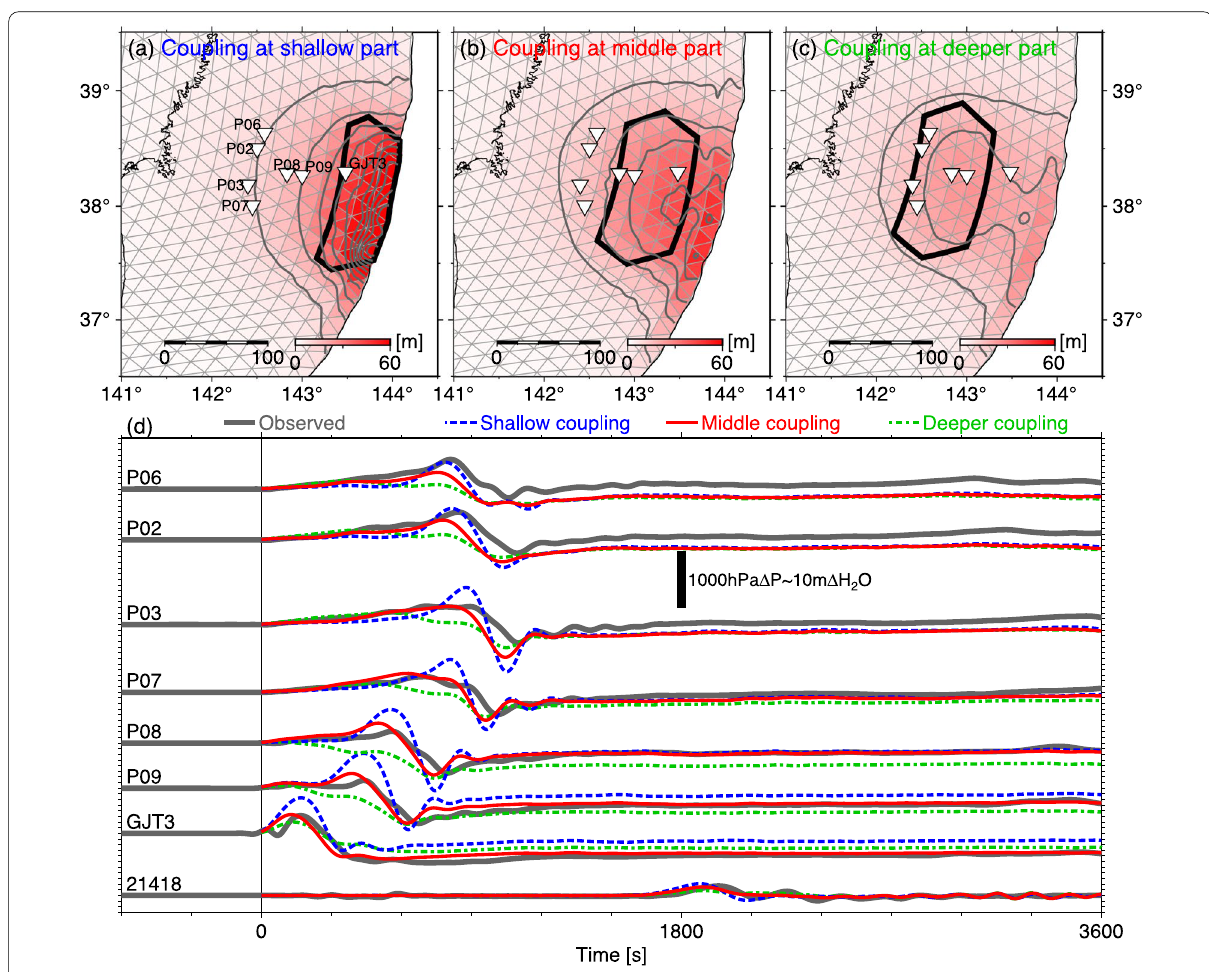
Fig. 10 Numerical evaluation of plate coupling area location. a – c Slip distribution assuming coupling at the shallowest, middle, and deeper portions of the plate boundary, respectively. Polygons drawn with thick black lines denote the regions where the stress drop was assigned. d Comparison between the observed (gray) and simulated waveforms (colored) at representative